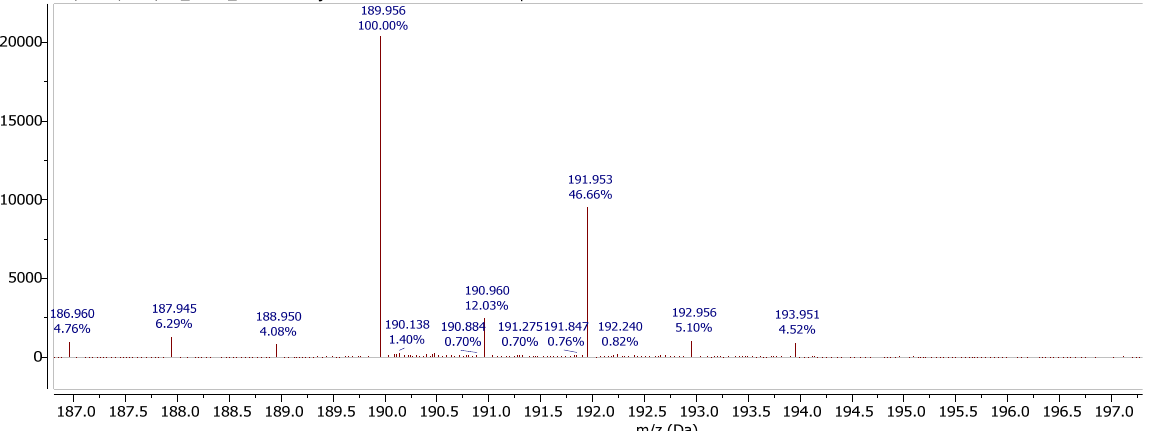
Figure 4. A region (187–197 Da) of the ASAP-MS spectrum obtained from the sample of ( 3 ) generated in this study according to the experimental. Y-axis is total ion count.